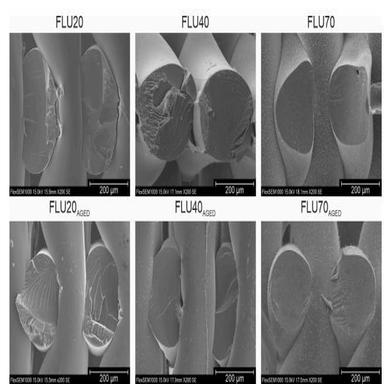
Scanning electron microscopy images of 3D printed tablets (cross-sections, magnification 200×).